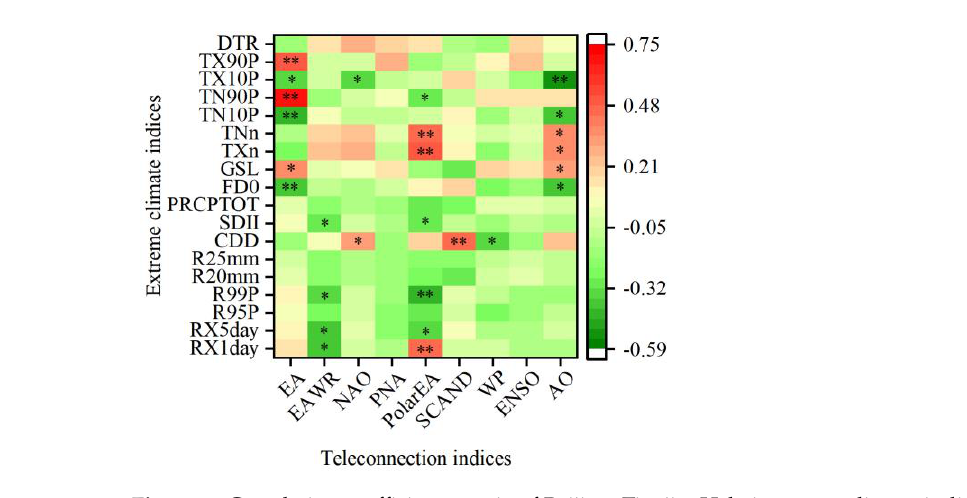
Figure 8. Correlation coefficient matrix of Beijing–Tianjin–Hebei extreme climate indices and teleconnection types (** indicates a significance level of 0.01; * indicates a significance level of 0.05). Table 5. The average wavelet coherence (AWC) and the numbers of power (PNPS) of the wavelet transform coherence (WTC) between extreme climate indices and teleconnection patterns in the Beijing–Tianjin–Hebei